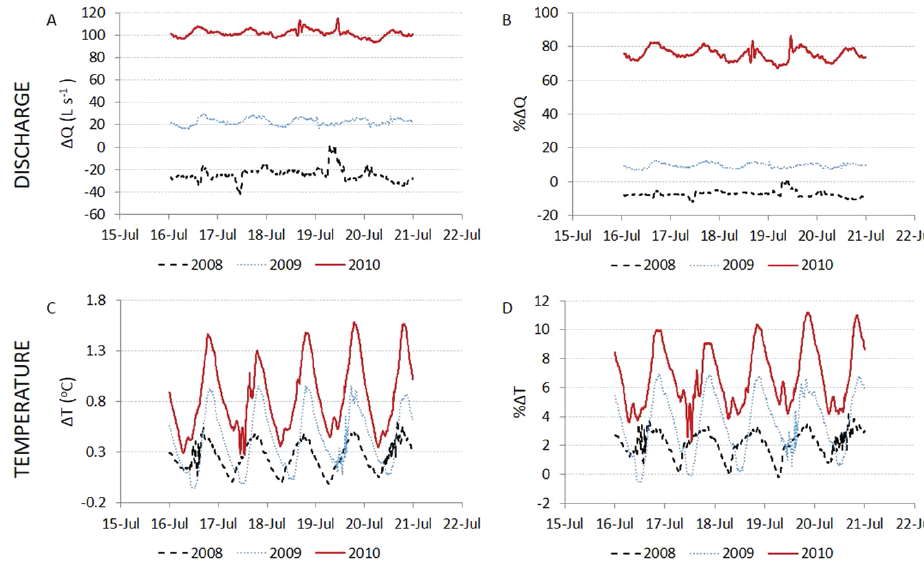
Figure 6. Change in discharge ( (cid:49)Q ) and temperature ( (cid:49)T ) over the study reach from 2008 to 2010. This 5-day period in July illustrates variability over shorter temporal scales. The % (cid:49)Q and % (cid:49)T are relative to the discharge and temperature at the upstream inflow location (PT515). The % (cid:49)Q were averaged over a 1h interval, while the % (cid:49)T represents 5min temperature values. Table 4. Sub-reach-scale mean residence times for 2008 and